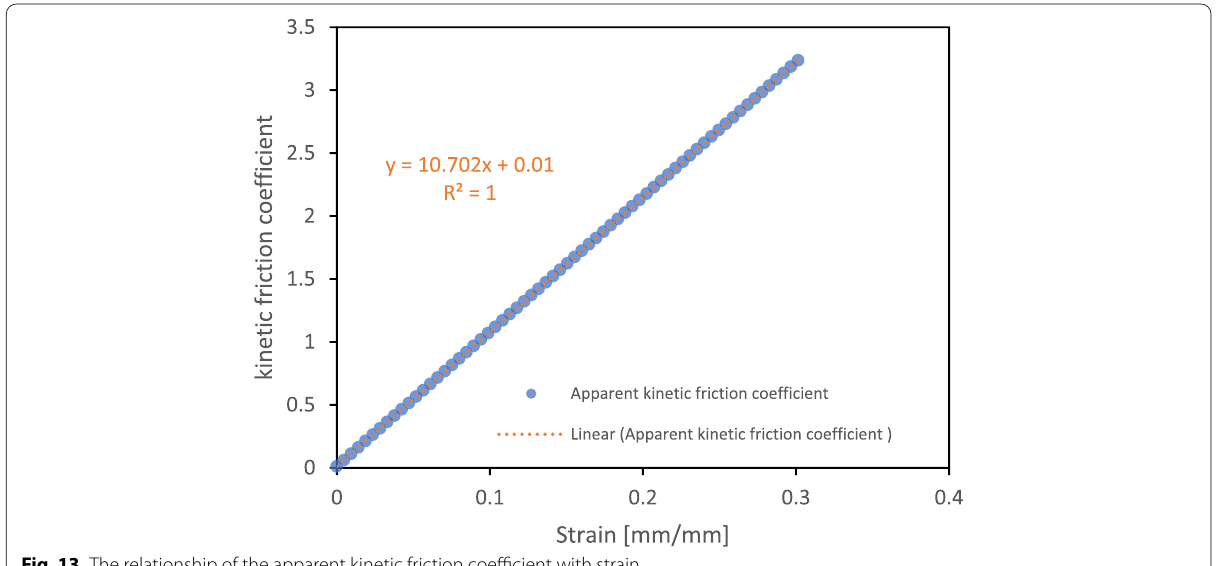
Fig. 13 The relationship of the apparent kinetic friction coefficient with strain